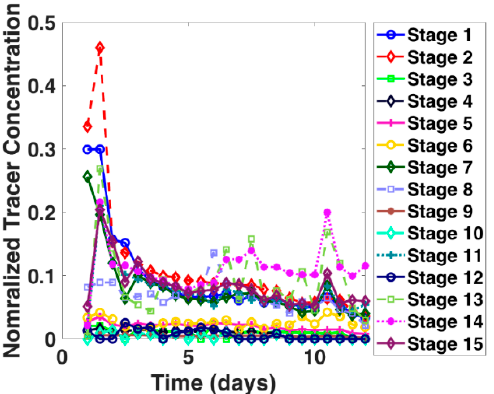
Figure 16. Tracer response curve from a multi-fractured well having 15 stages. Each stage was tagged with a unique chemical tracer.